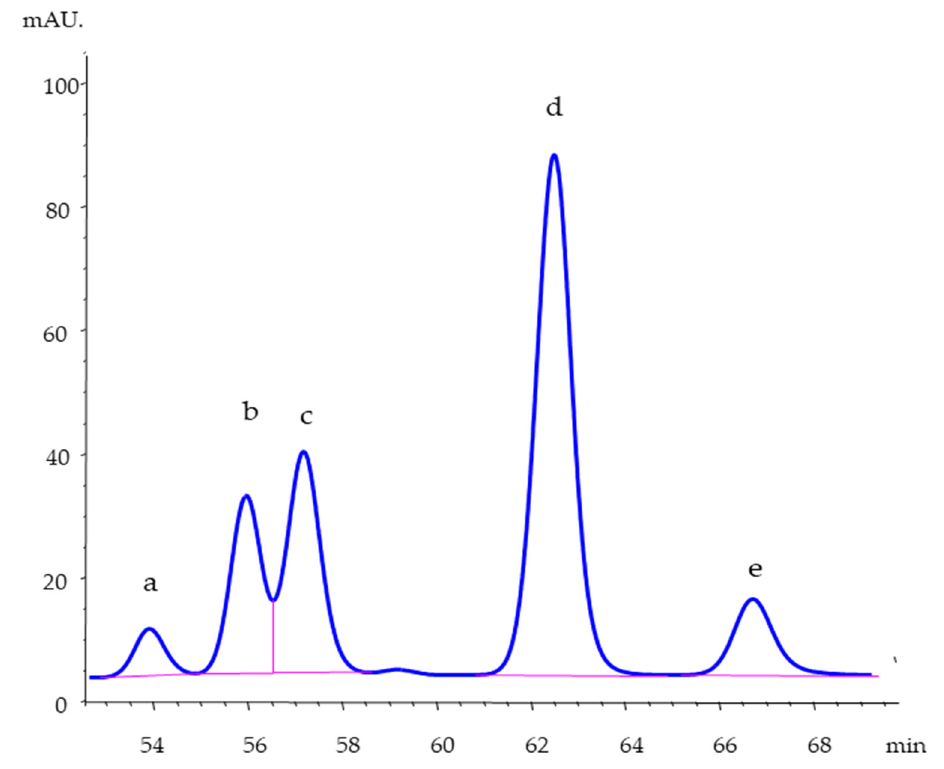
Figure 4. Chromatogram of phytosterols in espresso coffee from Costa Rica coffee-origin (sample No. 4), a for cycloartenol, b for campesterol, c for stigmasterol, d for β -sitosterol, and e for hexacosanol (internal standard) .